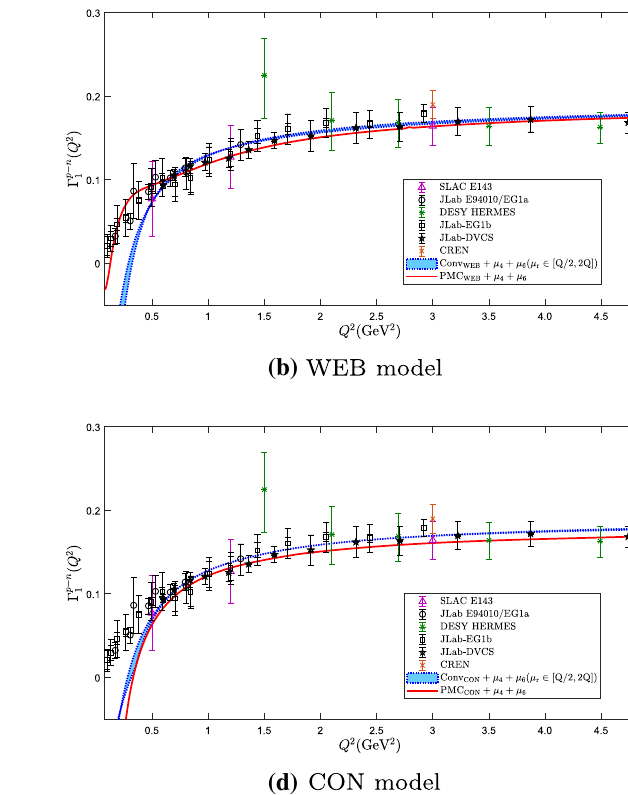
− n ( Q 2 ) with both leading-twist Fig. 4 The spin structure function (cid:3) p N 3 LO level and N 4 LO level before and after applying the PMC scale- 1 and high-twist contributions under four α s models: a the APT model; setting approach, respectively. The shaded band shows the prediction b the WEB model; c the MPT model; and d the CON model. The under conventional scale-setting approach by varying μ r ∈ [ Q / 2 , 2 Q ] . leading-twist perturbative contributions have been calculated up to The solid line is the scale-invariant PMC